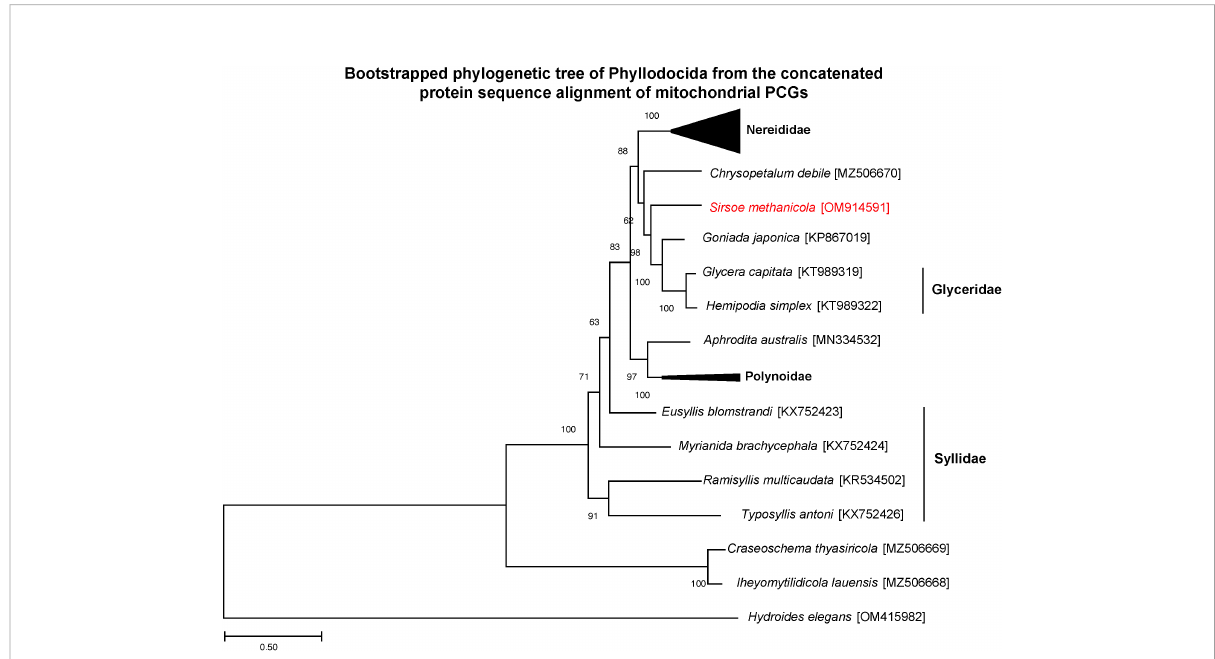
FIGURE 5 Bootstrapped maximum likelihood phylogenetic tree of concatenated protein sequences of 12 PCGs from the S. methanicola mitogenome (red text) in relation to mitogenomes available from the order Phyllodocida . The tree was constructed by MEGAX from the concatenated 2,648-aa alignment from 35 mitochondrial genomes. The tree with the highest log likelihood ( – 62222.03) is shown, with branch lengths indicating the number of substitutions per site. Bootstrap values on tree nodes indicate the percentage of trees, based on 100 replicates, in which taxa from a node are clustered together. The outgroup species used was Hydroides elegans from the polychaete order Sabellida . Accession numbers of all mitogenome sequences used are provided in Table